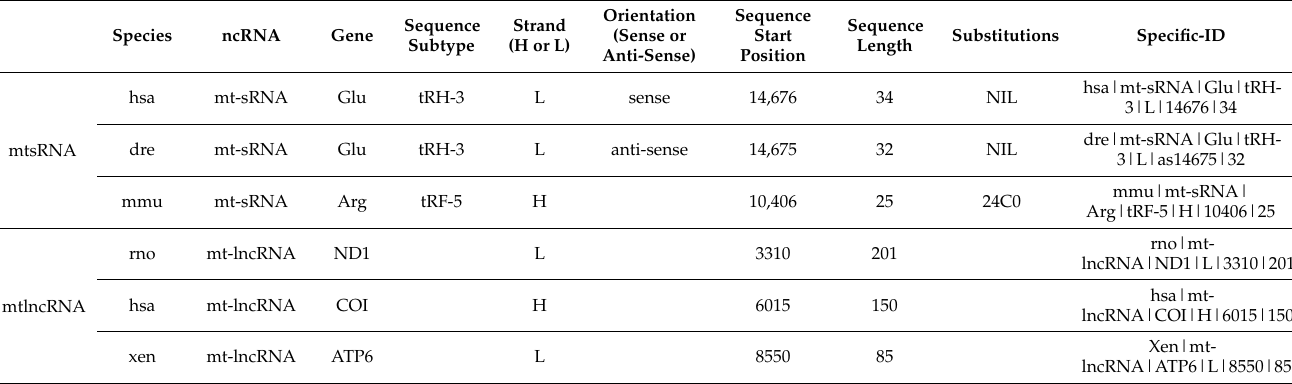
Table 2. Examples of nomenclature for mt-sRNA and mt-lncRNA with individual field separator values. The column “Specific-ID” shows the nomenclature and the values inside the field separators correspond, in order, to the values in the column names “Species” through “Substitutions” (from left to